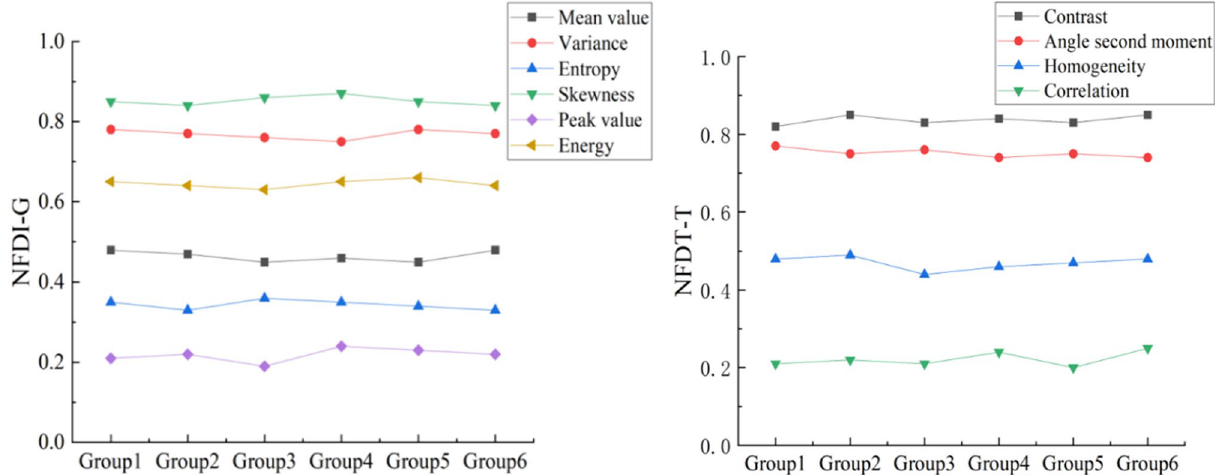
Figure 11. Difference index of coal and gangue characteristics in different